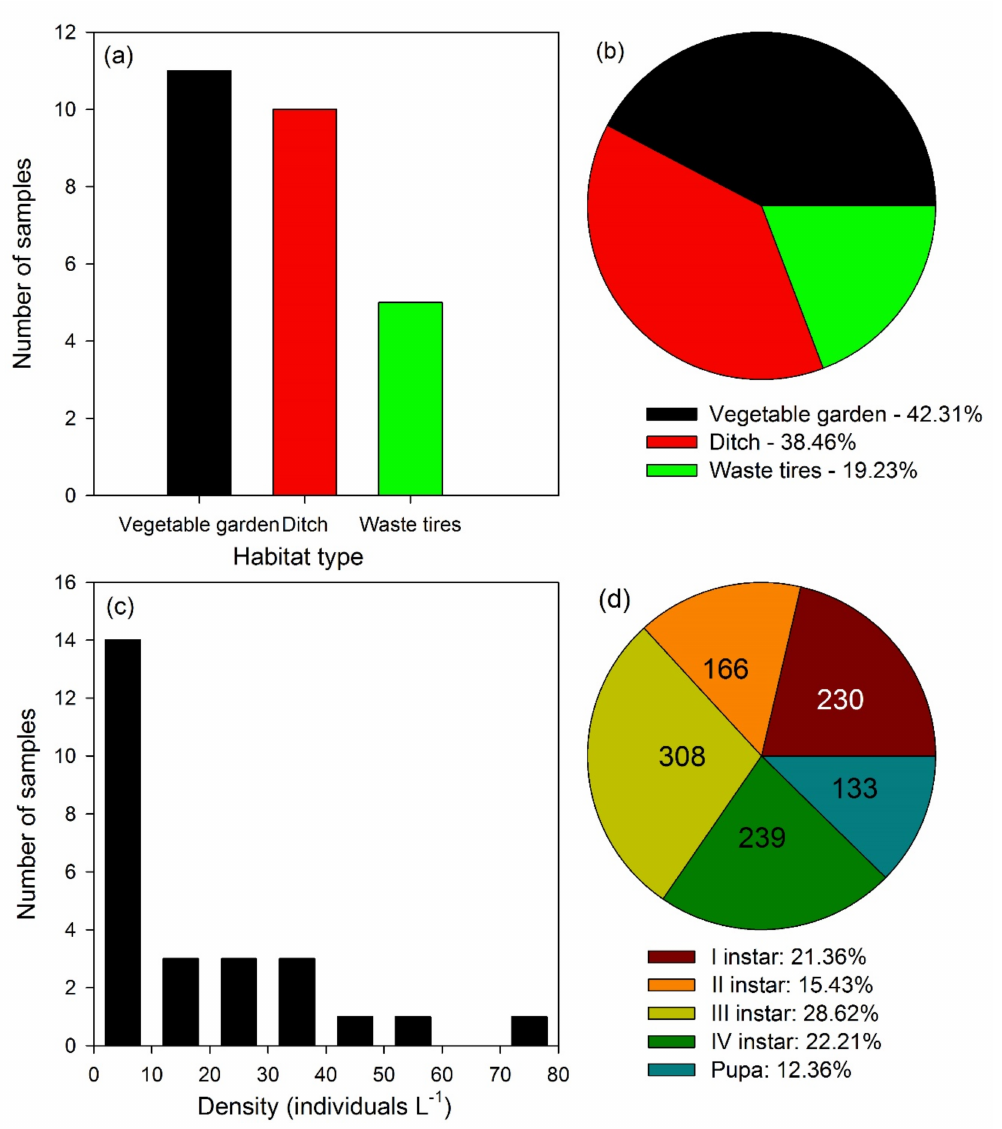
Figure 5. Number of mosquito larval samplings from di ff erent habitats surveyed in Taiwan ( a , b ). Aedes aegypti larval density over di ff erent samplings ( c , d